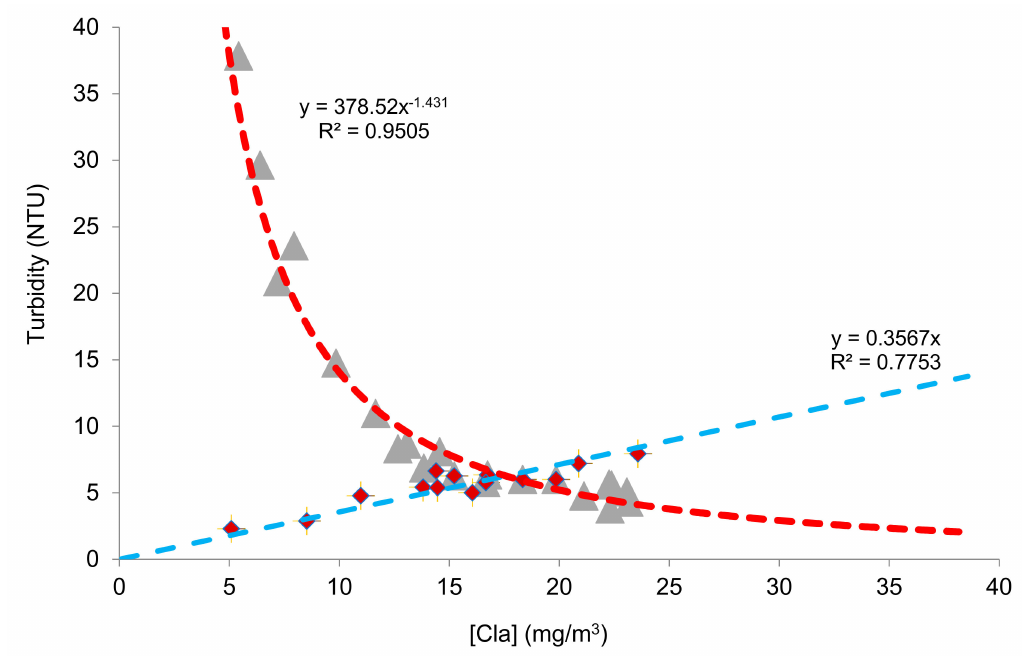
Figure 7. Di ff erent relationship between turbidity and [Cla]. Blue line, linear correlation between the variables; red line, inverse exponential relationship, where the turbidity is probably due to the presence of non-algal particles